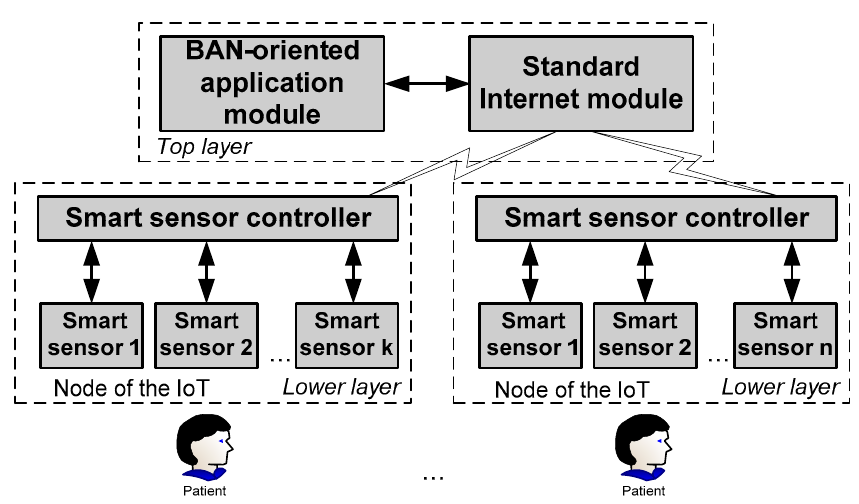
Figure 1. Two-layered sensor-networked IoT model to support BAN-oriented applications.